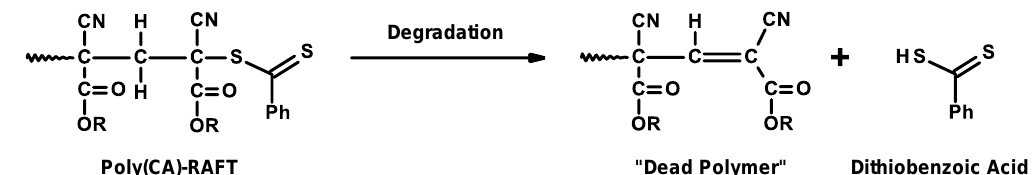
Scheme 17. Elimination of the RAFT end group.